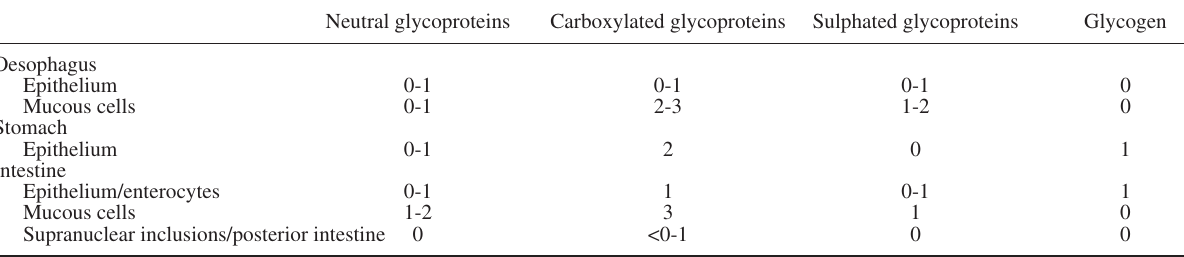
Table 3. – Histochemical distribution of glycoconjugates in oesophagus, stomach and intestine of the Merluccius merluccius larvae at 10 dph. Reaction colour intensity: 0, negative; 1, weak; 2, moderate; 3, strong.